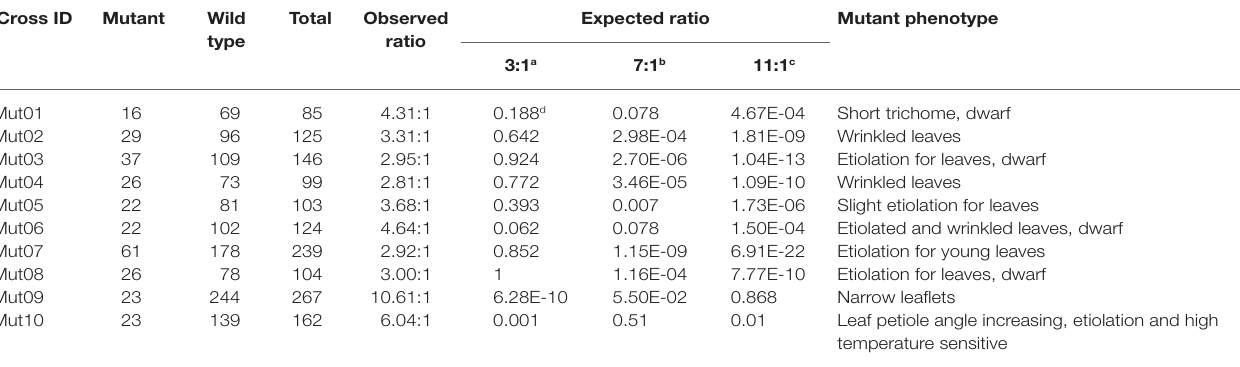
TABLE 1 | Phenotype ratio of progeny in 10 M2 populations. Cross ID